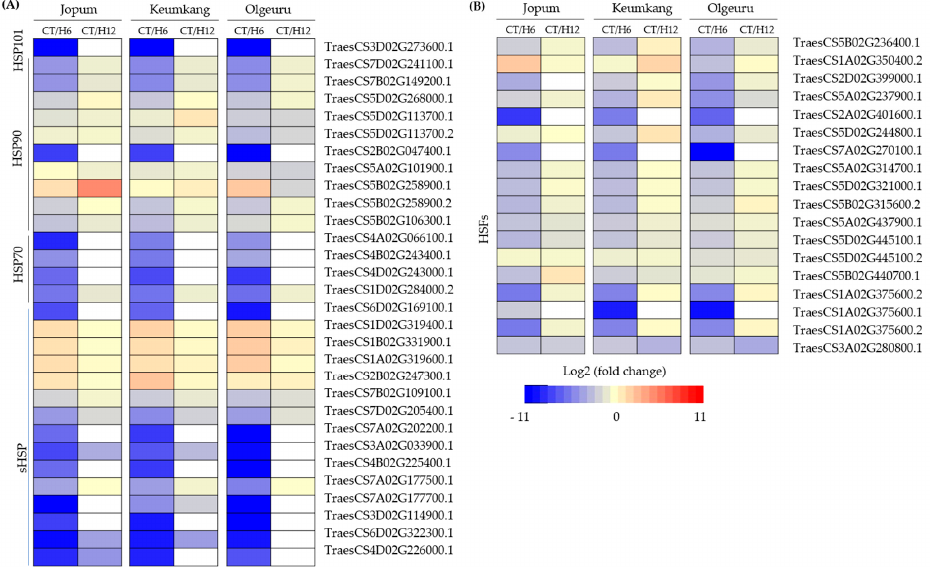
Figure 6. Heatmap of the temporal expression pattern of selected genes encoding HSPs ( A ), and HSFs ( B ). Upregulation is indicated in red; downregulation is indicated in blue; the white box indicates non-validation. The scale of color intensity is shown in the legend. HSP, heat shock protein; sHSP, small heat shock protein; HSFs, heat response transcription factors; CT, untreated control; H6, 6 h heat treatment; H12, 12 h heat treatment.